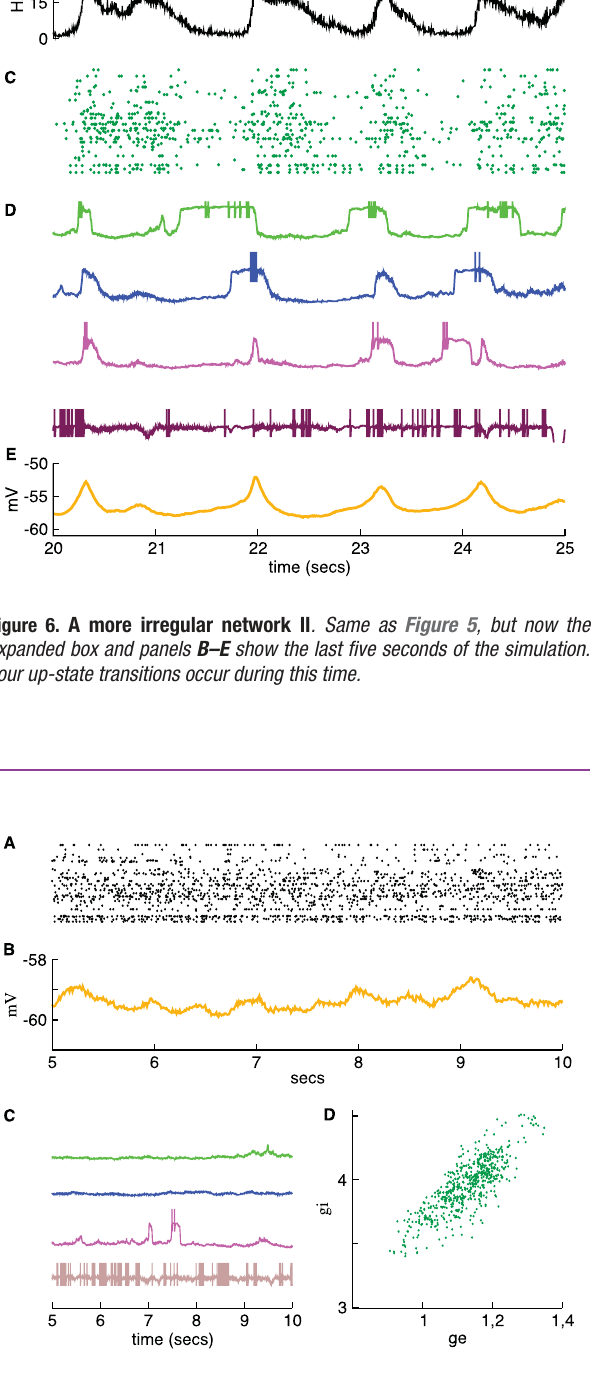
Figure 7. An active network . The inhibitory conductance of the noise was reduced to 50% of its value in the regular network. Neurons tend either to fire tonically or be inactive. (A) Raster. (B) Average membrane potential. (C) Membranepotentialtracesforthesameneuronsasin Figures2,5,and6 . (D) : Evolution of the average conductances. The average inhibitory conductance is now larger than the excitatory in agreement with experimental observations (Rudolph et al., 2007).